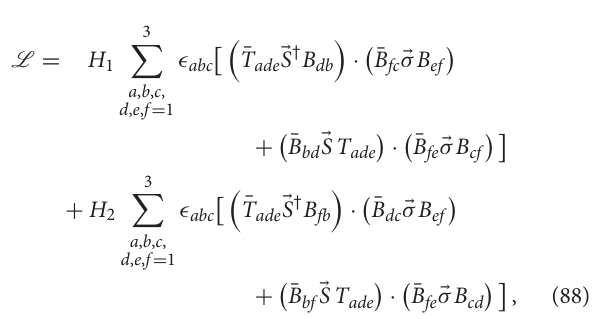
1 (2 δ ij i ǫ ijk σ k 3 − =